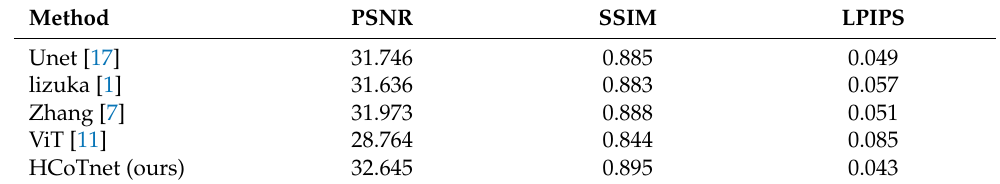
Table 1. Quantitative comparison results. Note that the results were obtained using 0.5% color hints.